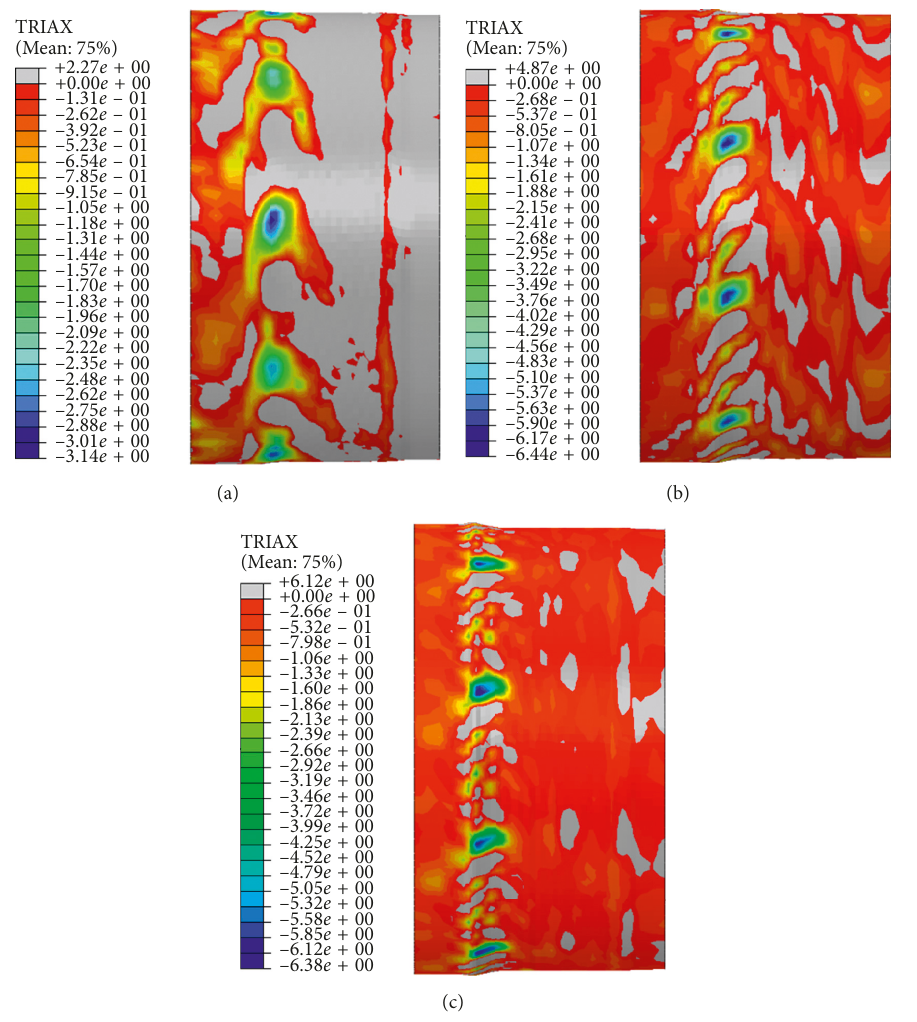
Figure 10: Cloud diagram of relative stress triaxiality under different feed ratios. (a) R f